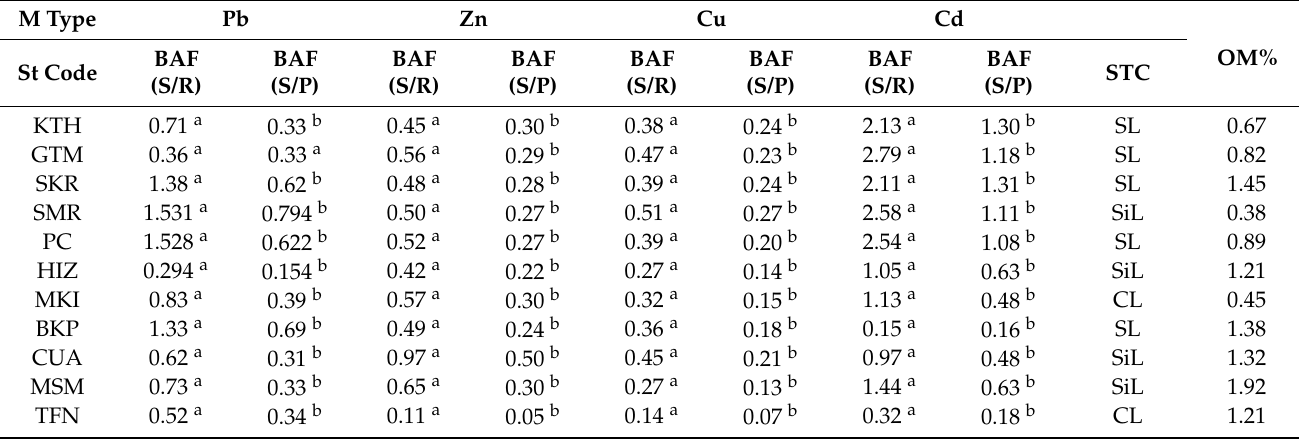
Table 1. Transfer factor (bio-accumulation) from a soil–root–intact plant collected from different abandoned habitats in Khyber Pakhtunkhwa,